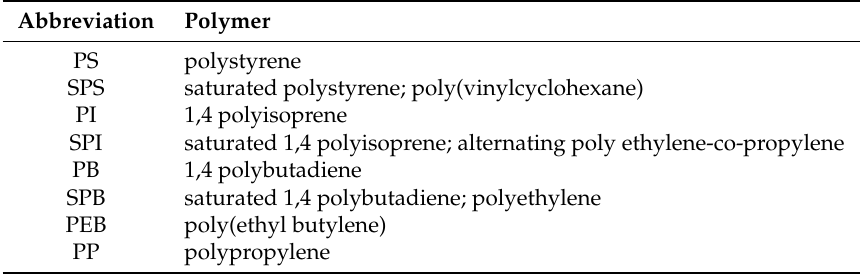
Table 4. Polymer